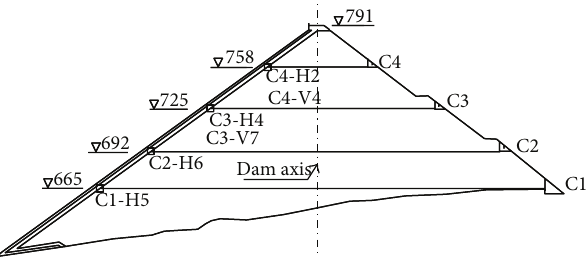
Figure 8: In-situ observation points along the interface at 0 + 630